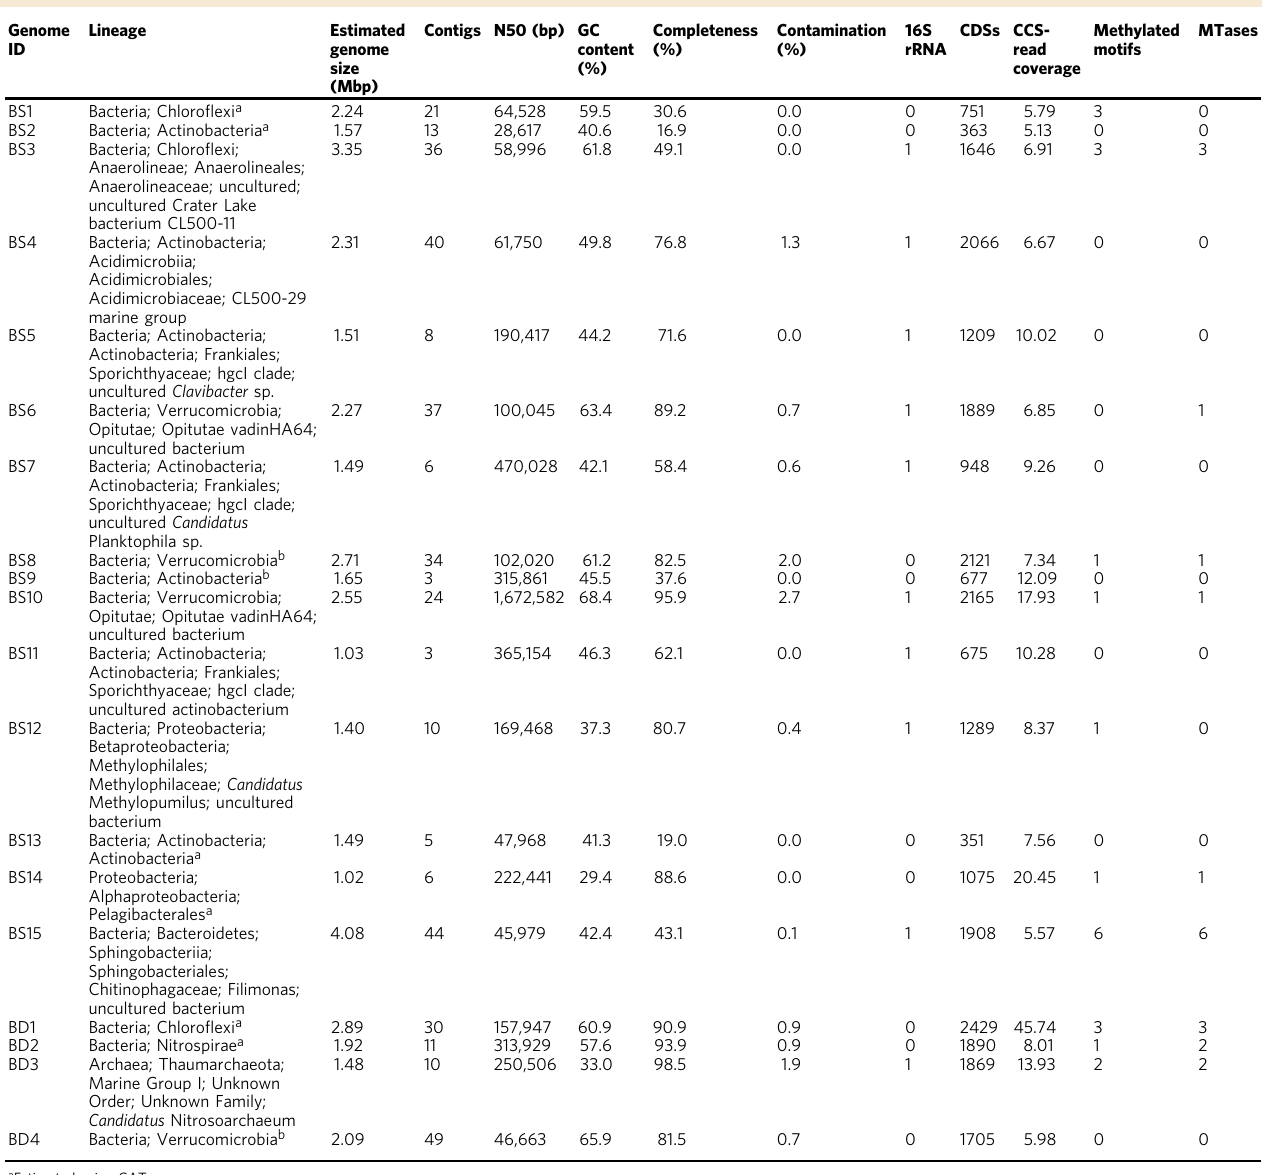
Table 2 Statistics for draft genomes Genome